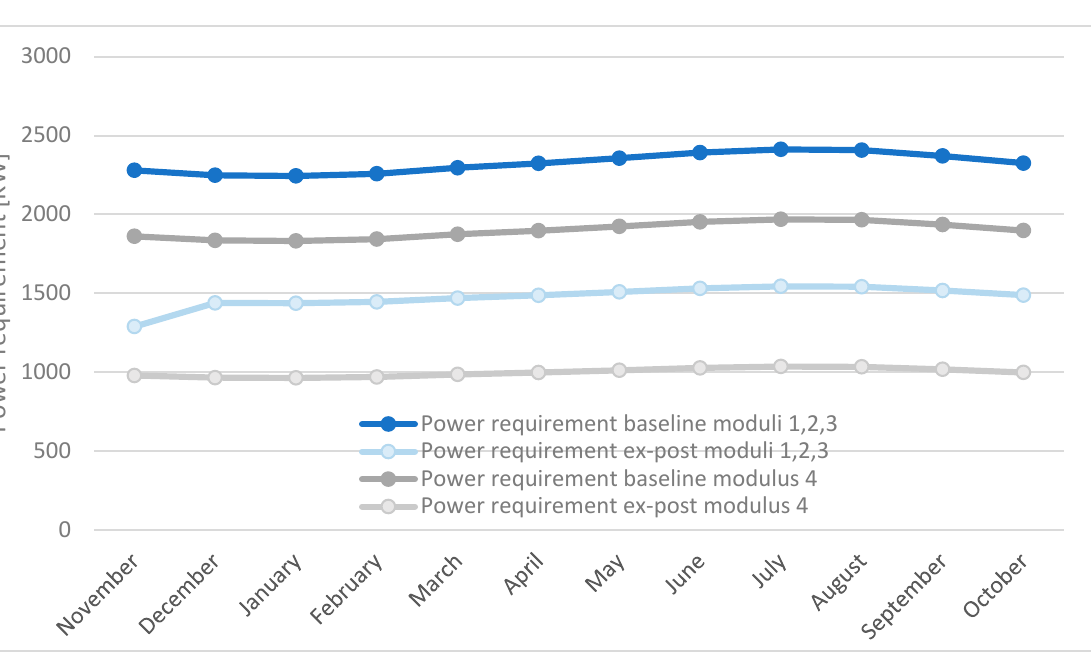
Figure 4. Power requirement for moduli 1, 2, 3, and 4.